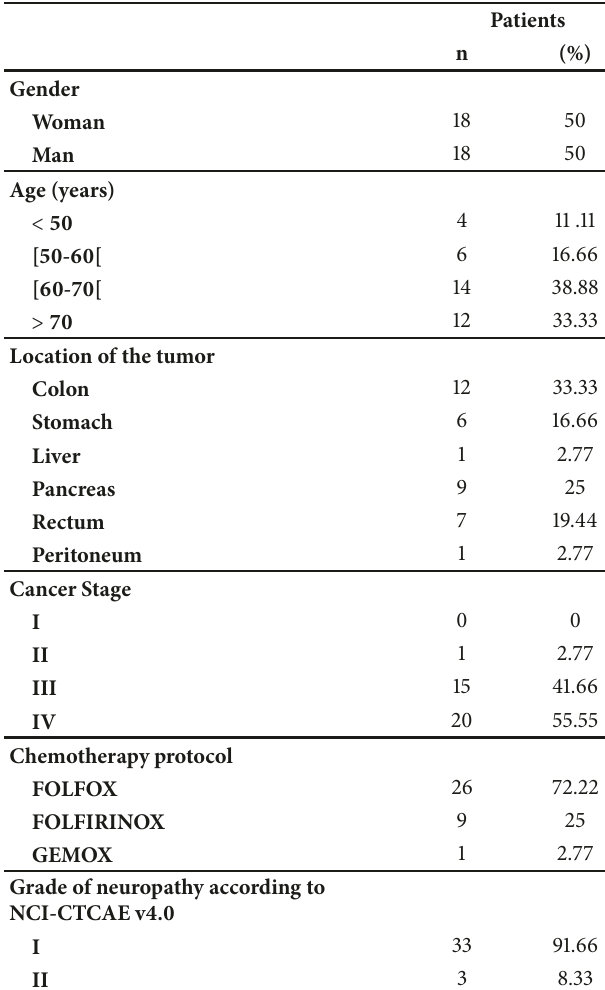
Table 2: Characteristics of patients included in Canaloxa study between April 2016 and March 2017 in the Oncology department of Groupe Hospitalier Paris Saint Joseph